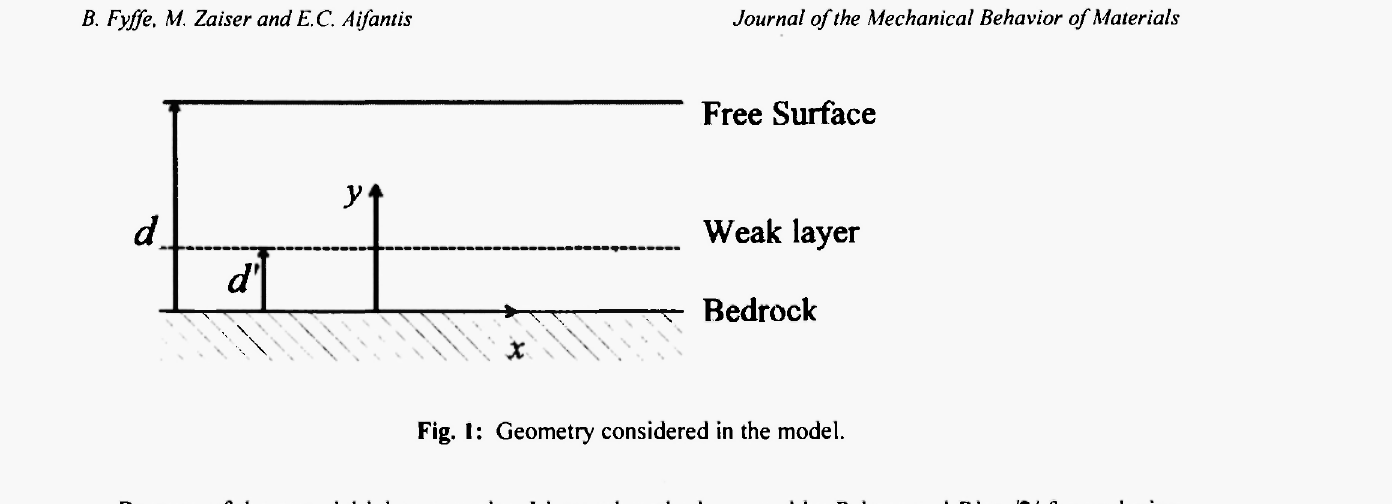
Fig. 1: Geometry considered in the